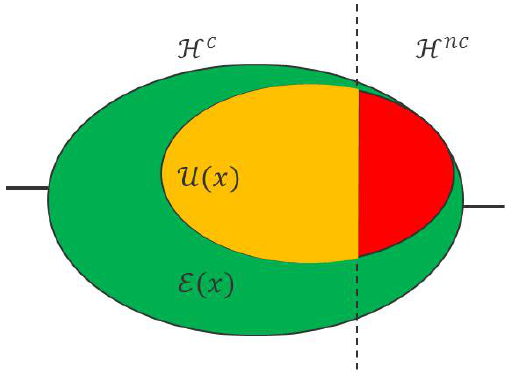
Figure 10: The verification risk measure is based on the verification loss L , the a priori estimated Figure 9: Illustration of the sets of subrequirements state of Y , and the effect u ( x ) of increasing H c , H nc , and how these are overlapped with examination effort x by the given examina- A A E A ( x A ) and U A ( x A ). The verification risk is tion estimated by means of the intersection (red part) of the unexamined set U A ( x A ) and the set of noncompliant requirements H nc . A